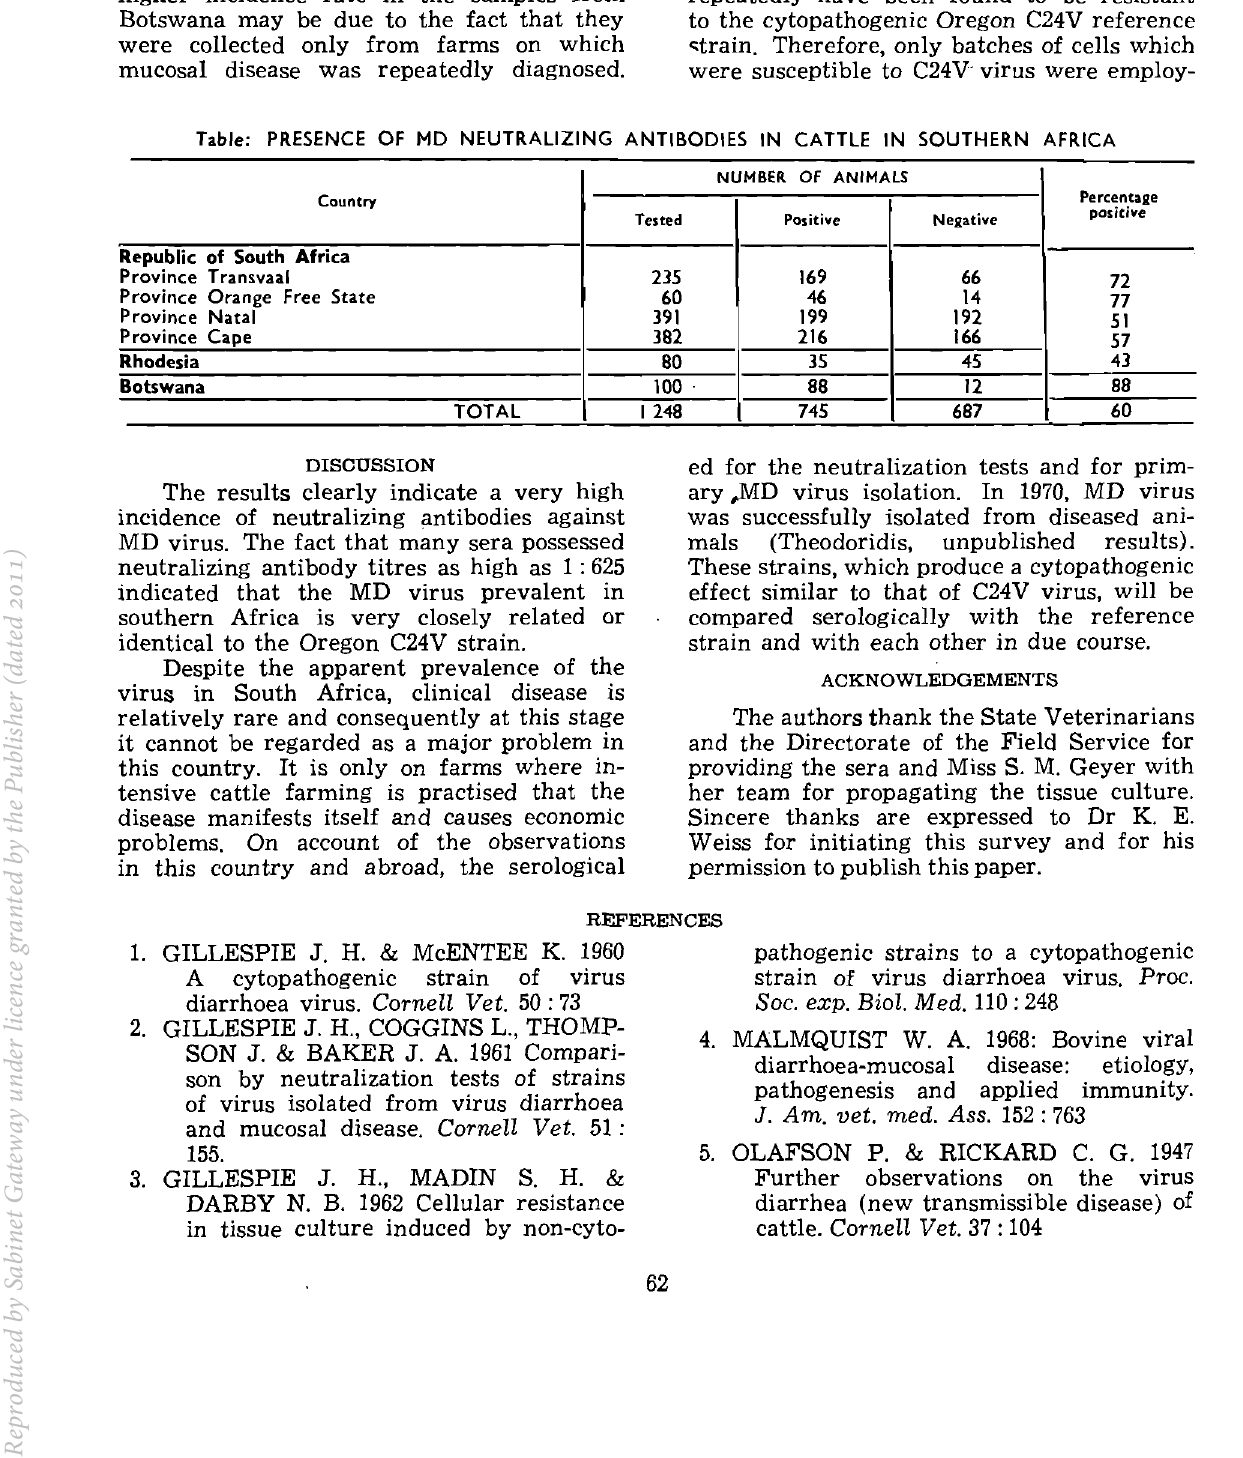
Table: PRESENCE OF MD NEUTRALIZING ANTIBODIES IN CATTLE IN SOUTHER.N AFRICA